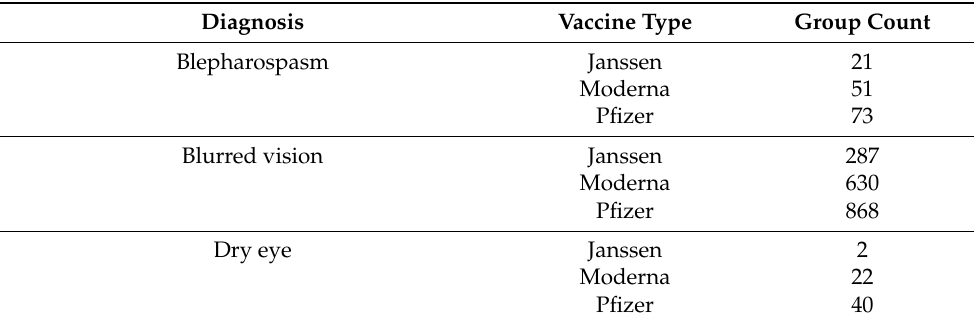
Table 2. Main adverse events grouped by the type of vaccine